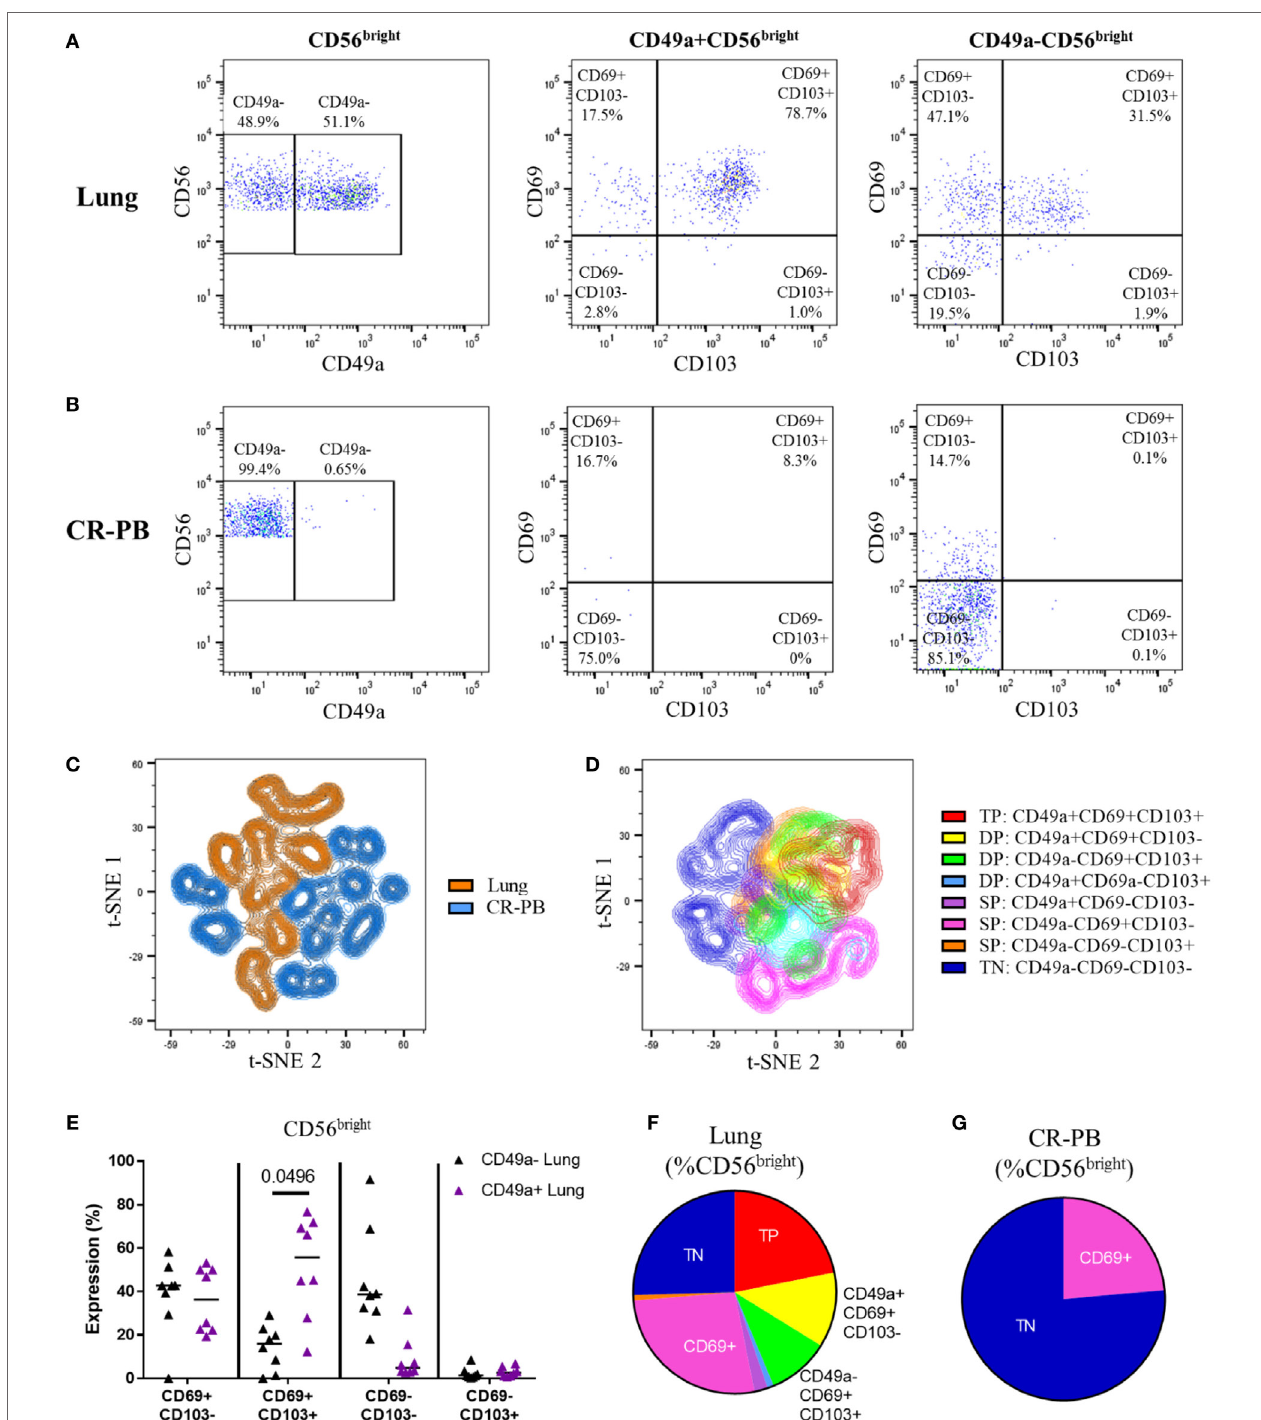
FigUre 5 | CD56 bright CD49a + lung natural killer (NK) cells co-express CD69 and CD103. (a,B) Gating strategy to define co-expression of CD69 and CD103 on CD49a + and CD49a − populations of CD56 bright NK cells isolated from the lung (a) and blood [peripheral blood from cancer resection donor (CR-PB)] (B) . (c) t-SNE plot of CD56 bright NK cells in matched blood (blue) and lung (orange) based on CD49a, CD69, and CD103 expression ( N = 16, 8 individuals). From each sample, 300 events were randomly selected. Perplexity = 20, 1,000 iterations. (D) t-SNE plot of CD56 bright NK cells isolated from the lungs based on CD49a, CD69, and CD103 expression ( N = 8). Cells are colored according to the expression of each marker, showing single-positive (SP), double-positive (DP), and triple-positive (TP) populations. From each sample, 600 events were randomly selected. Perplexity = 20, 1,000 Iterations. (e) Quantification of CD69 and CD103 expression of CD49a + and CD49a − CD56 bright NK cell populations of the lung and blood. Lines described medians, statistical analysis by Friedman’s test with Dun’s correction ( N = 8). Overall P -value < 0.001. (F,g) Quantification of residency marker expression on CD56 bright NK cells of matched blood (F) and lung (g) . Key as shown in panel (D) .